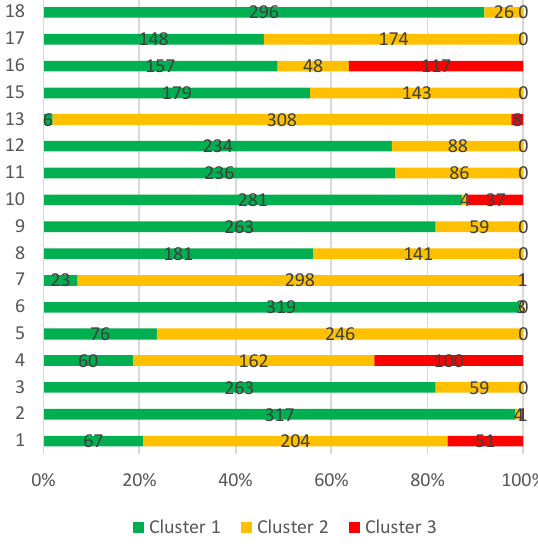
Figure 8: Resume Grouping Based on 18